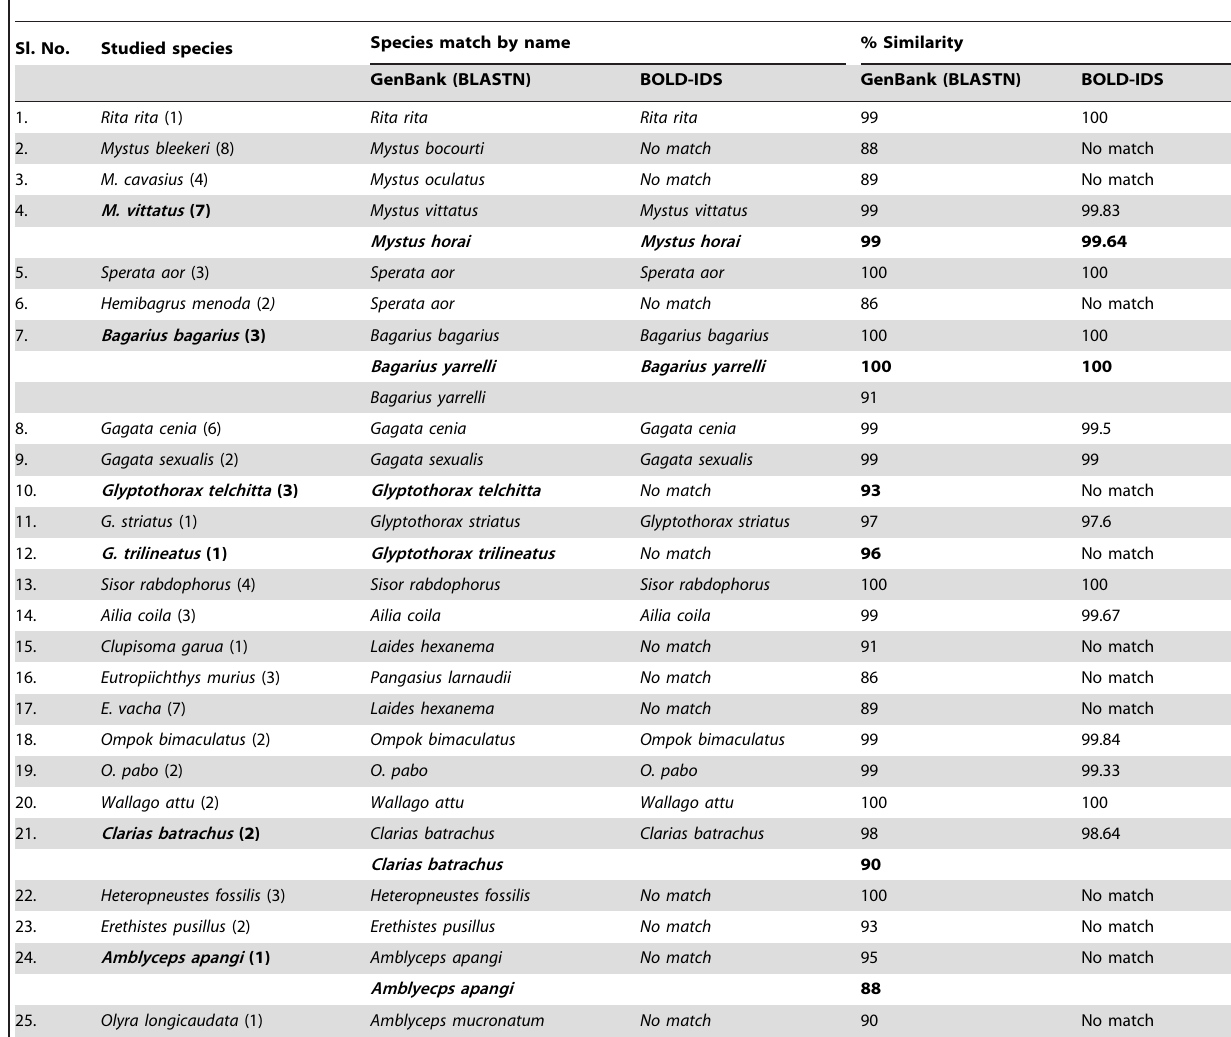
Table 1. Summary of identification based on each species consensus barcoded sequence using BLASTN search from GenBank and BOLD Identification System (BOLD-IDS).